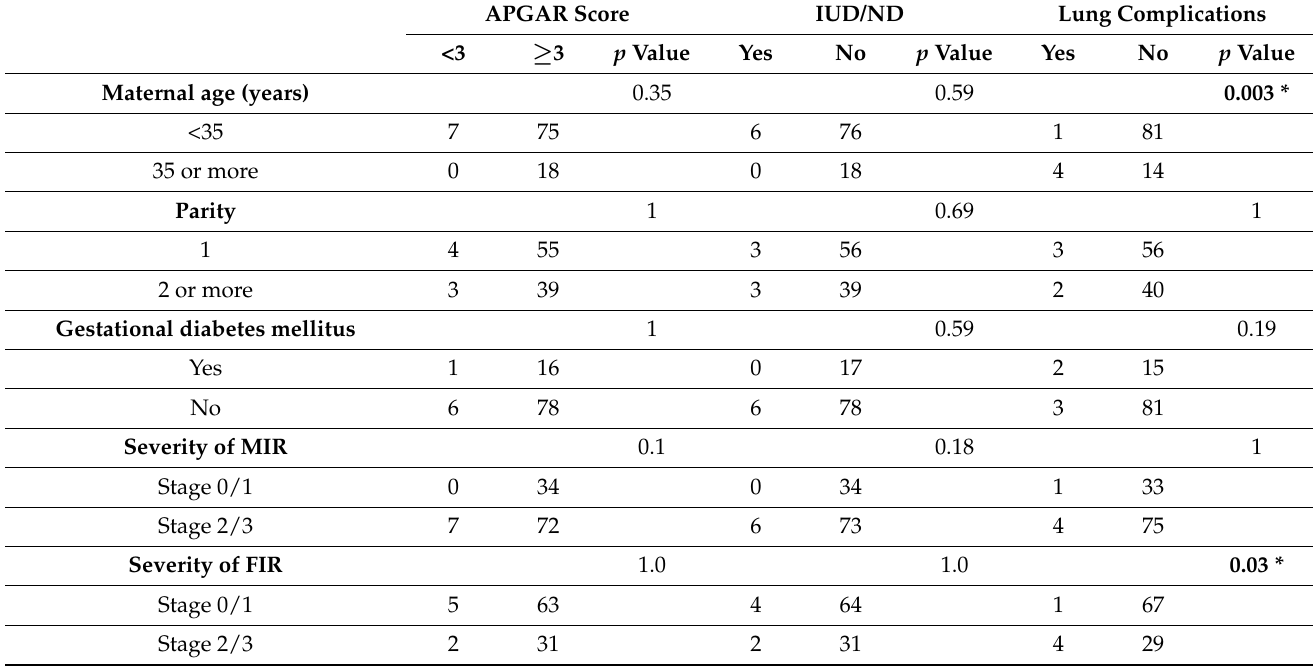
Table 2. Correlation between clinicopathological parameters of cases with chorioamnionitis and their perinatal outcomes.